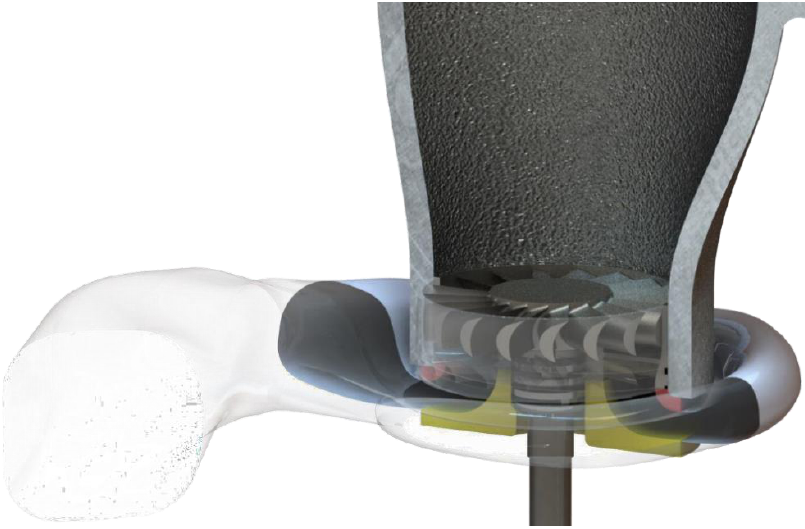
Figure 50. Axial turbine assembly concept with OEM scroll (inner surface only) and aerodynamic adapters.